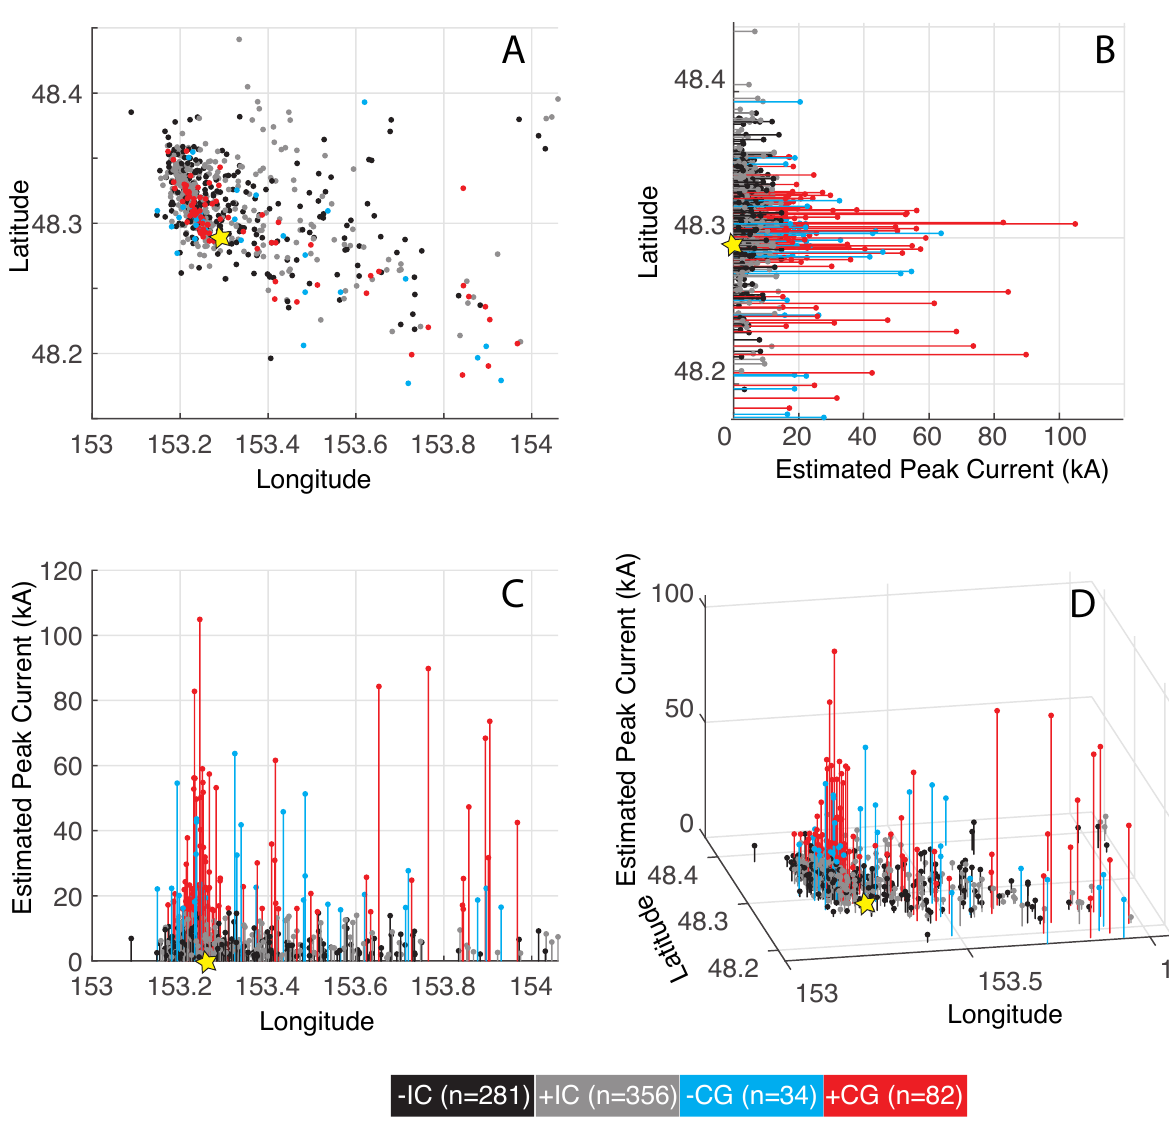
Figure 2: Lightning stroke locations and characteristics detected by the GLD360 network during the 21–22 June 2019 eruption of Raikoke volcano. [A] Lightning locations in decimal degrees; [B,C] estimated peak currents compared to latitude and longitude; [D] Lightning locations in decimal degrees with estimated peak currents shown. Yellow star represents location of Raikoke volcano; colors delineate lightning type (IC = in-cloud, CG = cloud-to-ground) and positive or negative polarity. In legend ‘n’ refers to the number of detected strokes for the given